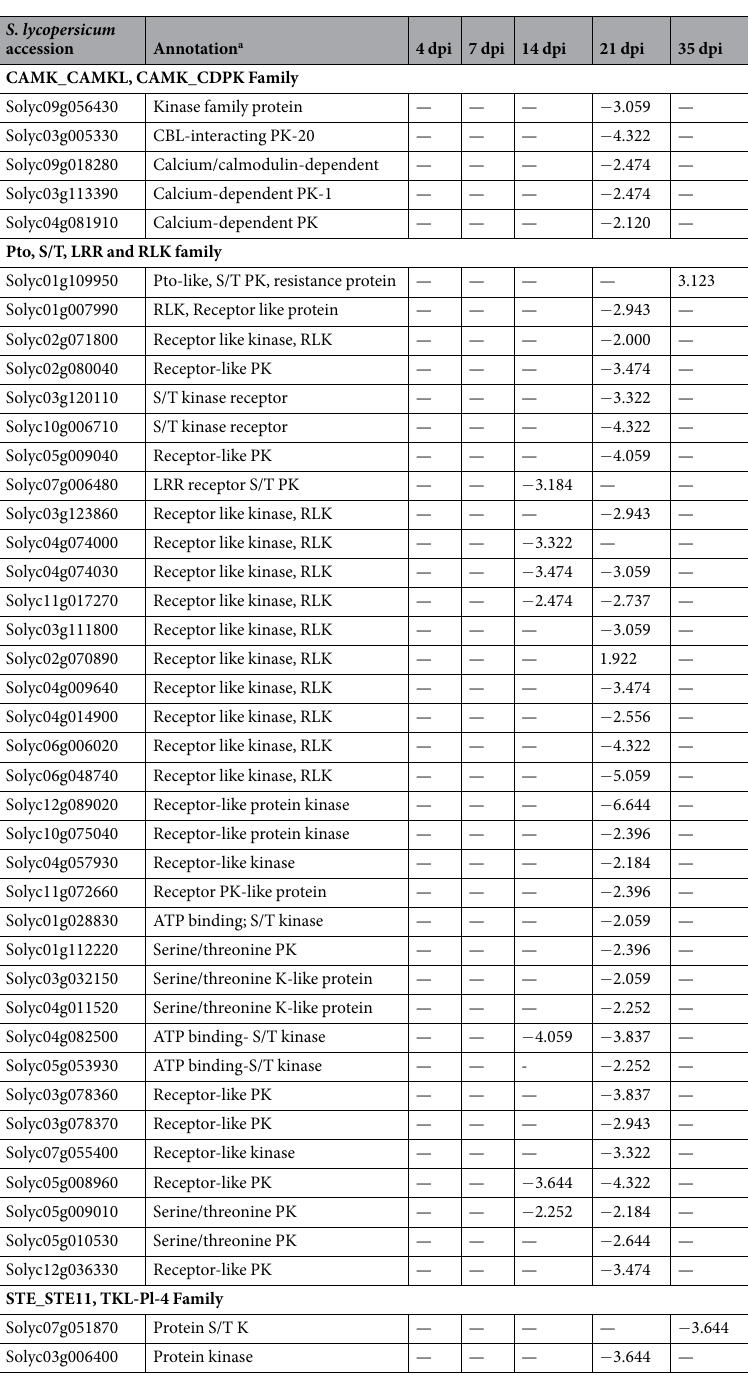
— − 2.396 — Solyc01g028830 ATP binding; S/T kinase — — — − 2.059 — Solyc01g112220 Serine/threonine PK — — — − 2.396 — Solyc03g032150 Serine/threonine K-like protein — — — − 2.059 — Solyc04g011520 Serine/threonine K-like protein — — — − 2.252 — Solyc04g082500 ATP binding- S/T kinase — — − 4.059 − 3.837 — Solyc05g053930 ATP binding-S/T kinase — — - − 2.252 — Solyc03g078360 Receptor-like PK — — — − 3.837 — Solyc03g078370 Receptor-like PK — — — − 2.943 — Solyc07g055400 Receptor-like kinase — — — − 3.322 — Solyc05g008960 Receptor-like PK — — − 3.644 − 4.322 — Solyc05g009010 Serine/threonine PK — — − 2.252 − 2.184 — Solyc05g010530 Serine/threonine PK — — — − 2.644 — Solyc12g036330 Receptor-like PK — — — − 3.474 — STE_STE11, TKL-Pl-4 Family Solyc07g051870 Protein S/T K — — — — − 3.644 Solyc03g006400 Protein kinase — — — − 3.644 — Table 3. List of differentially expressed protein kinases (PKs) in Sw-7 compared to the S-line after TSWV inoculation. a PK, protein